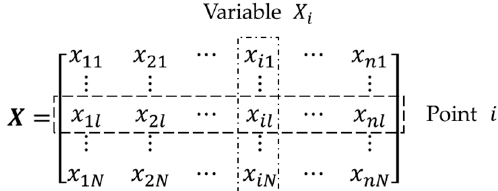
Figure 2. The elements of the samples of wind power outputs and loads.